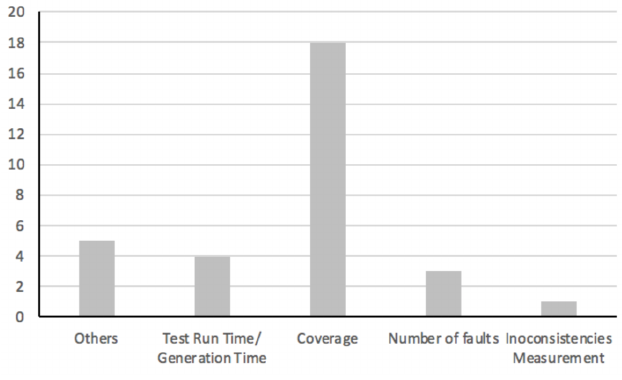
Figure 8. Distribution of studies under different evaluation